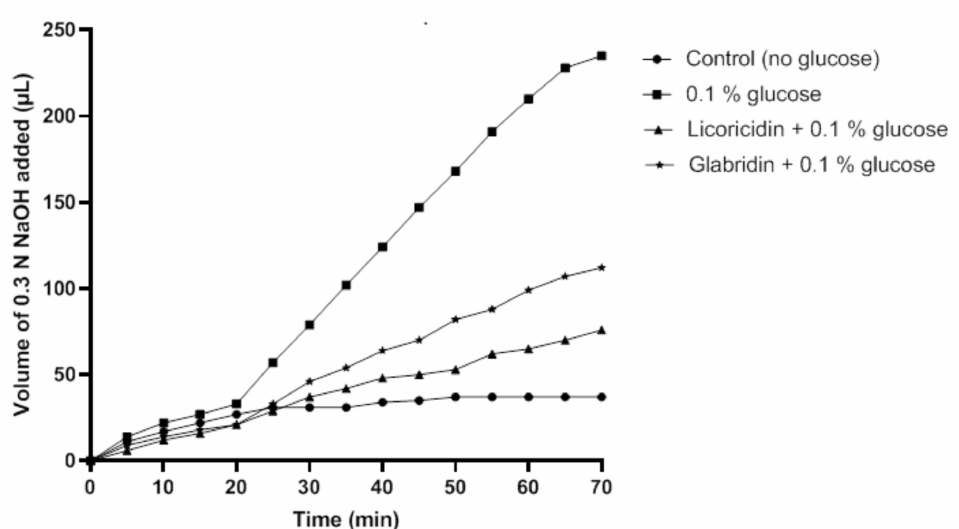
Figure 4. Effect of licoricidin and glabridin on acid production by Streptococcus mutans ATCC 25175. Glycolysis was monitored at a constant pH (7.0) by automatic titration of the acid produced. The volume of 0.3 N NaOH required to maintain a constant pH of 7.0 was determined over a 70-min period at 37 ◦ C. Four independent experiments were performed, and a representative set of data is